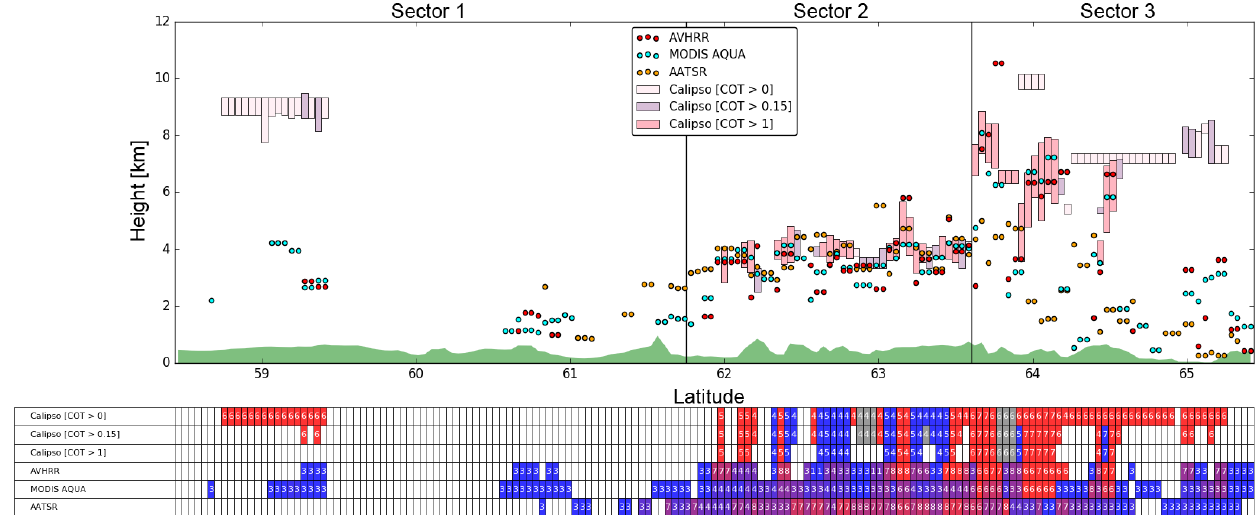
Figure 12. Study area NA2 (North America 2). As Fig. 10, but on 2 July 2008, 20:58LST ( n =